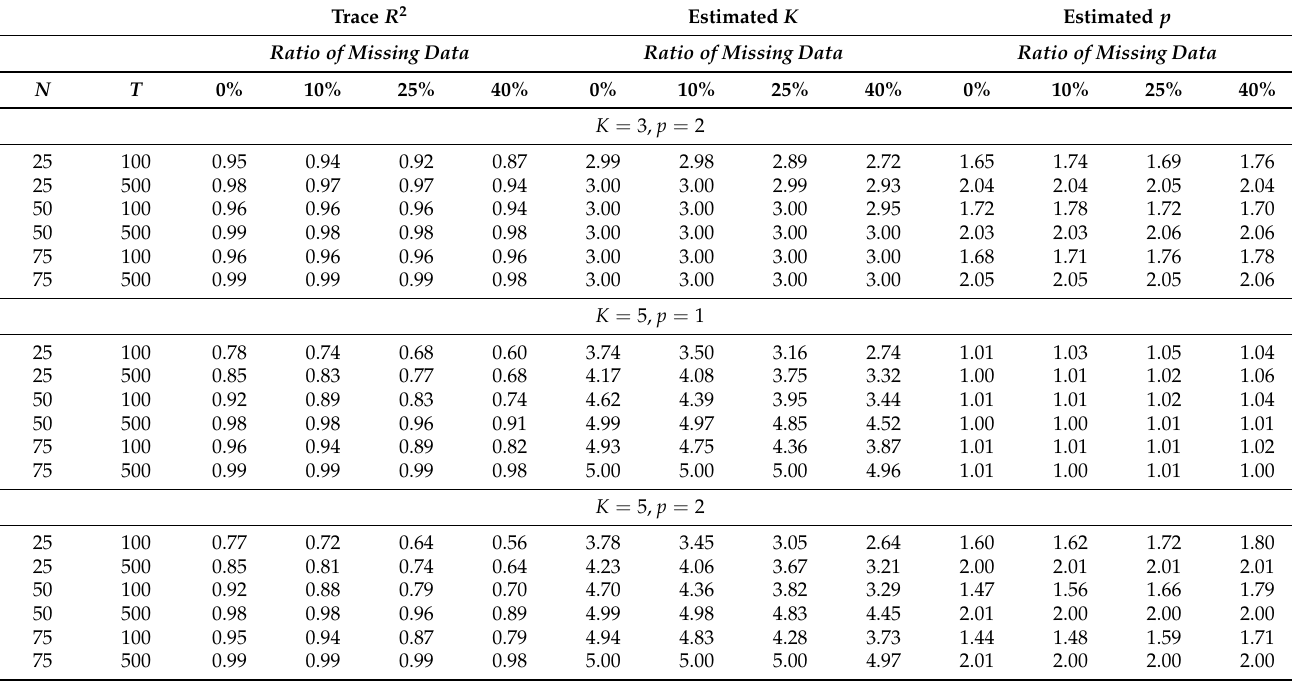
Table A6. Means of trace R 2 for random ADFMs of low dimensions using our two-step estimation method with m = 1